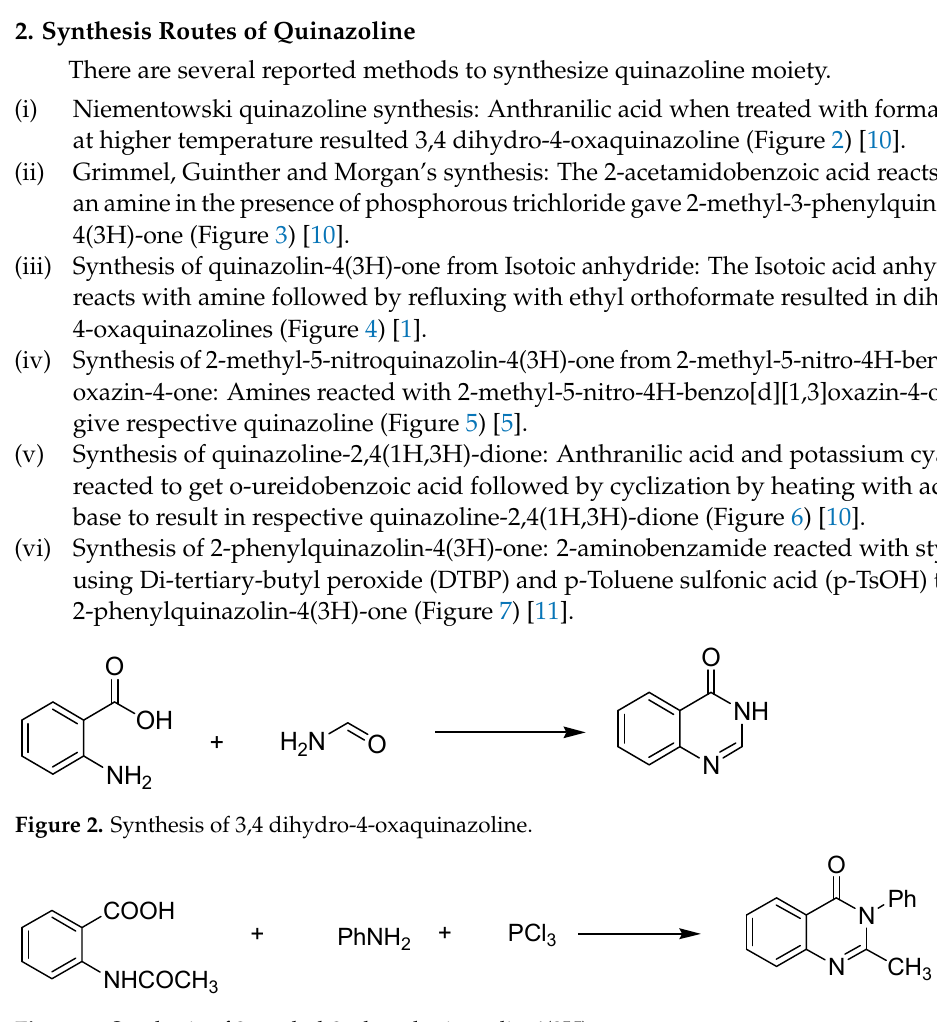
Figure 4. Synthesis of quinazolin-4(3H)-one. Figure 3. Synthesis of 2-methyl-3-phenylquinazolin-4(3H)-one.